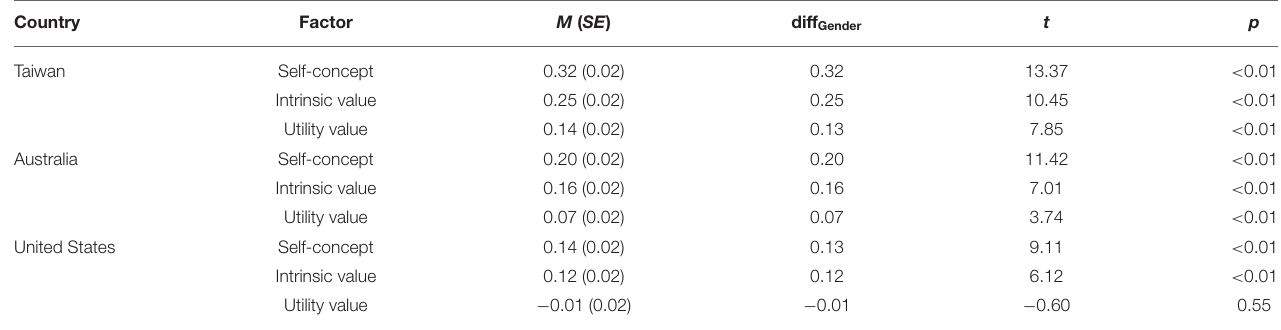
TABLE 5 | Comparisons of latent means of factors between females and males in the three countries.